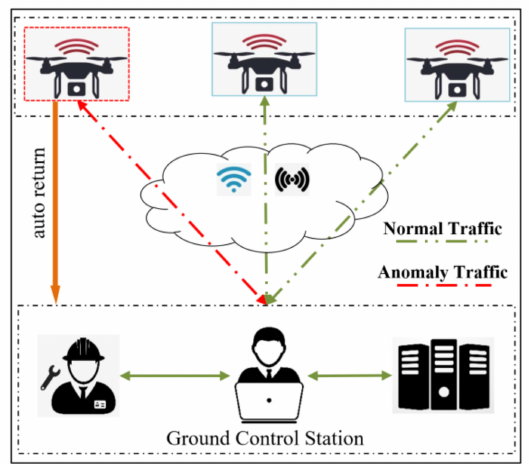
Figure 1. Main components in the UAV anomaly detection